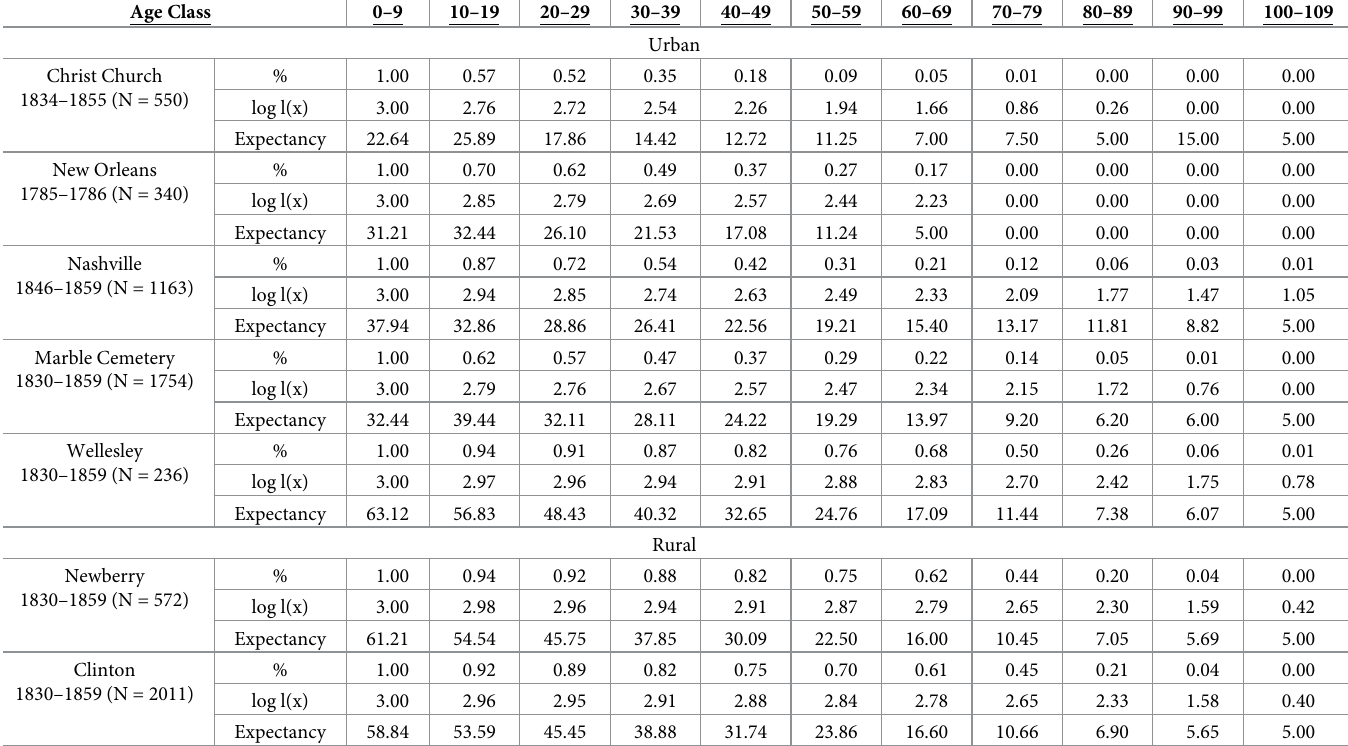
Table 1. Percentage and log survivorship and life expectancy for multiple cemeteries. See text for details.